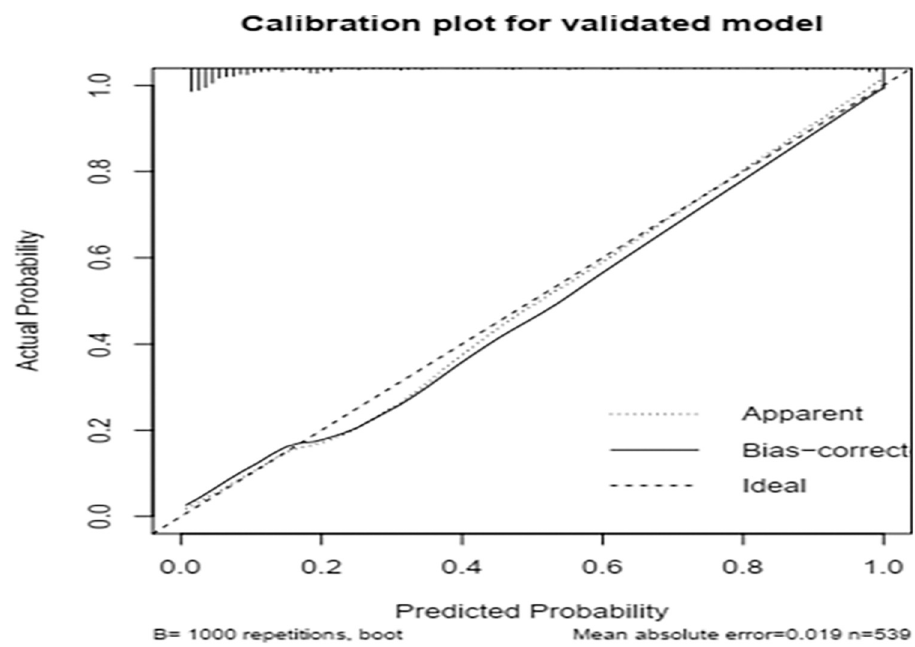
Fig 2. Calibration plot of the validated model: Predicted probability versus actual probability of poor outcomes of SCAP in under five children.